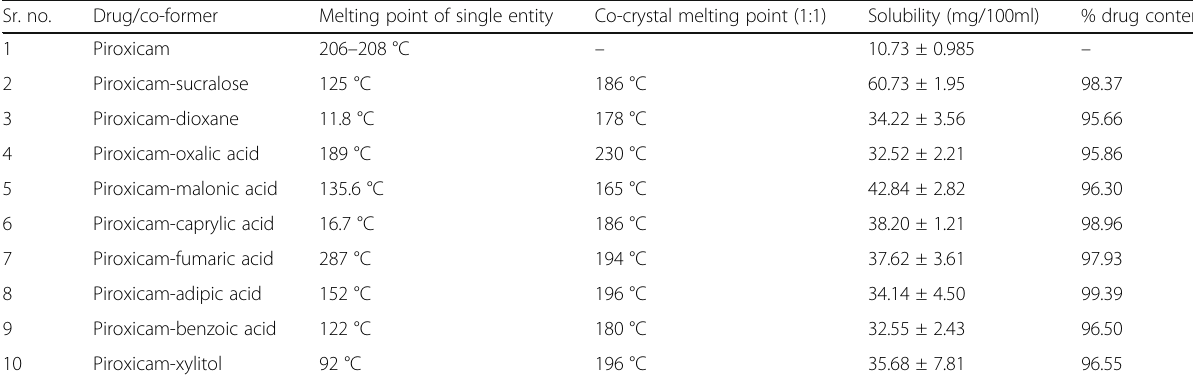
Table 2 Melting point, solubility, and % drug content of co-crystals Sr. no.